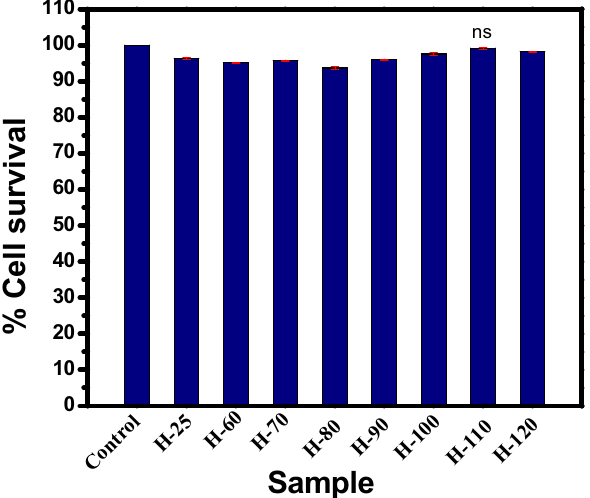
Figure 6: Cell viability study of hydrogel samples for 24 h. Vertical bars representing mean ± SEM. Signi fi cance was tested using one - way ANOVA followed by Tukey post - hoc test.